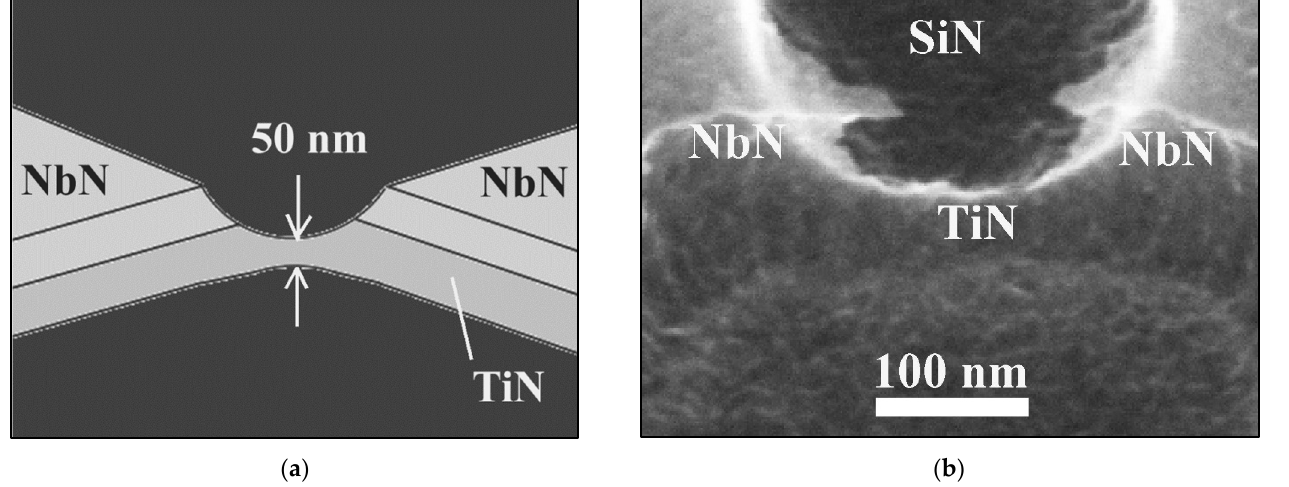
Figure 2. ( a ) Schematic view of a NbN-TiN-NbN nJJ. ( b ) SEM image of a NbN-TiN-NbN nJJ pre- pared using RIE. The image was recorded at an accelerating voltage of 15 kV and a sample tilt angle of 45°.